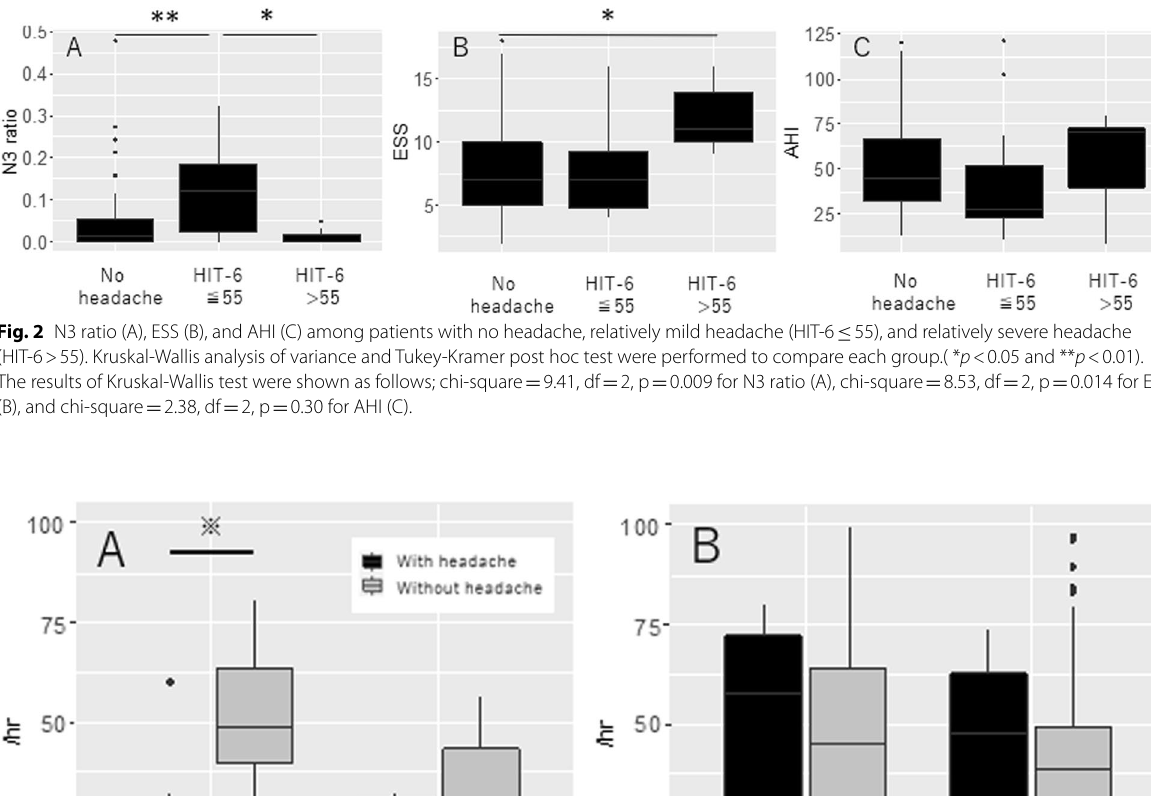
Fig. 3 AHI and AROI in patients with and without sleep apnea headache. Results for female are shown in A, and results for male in B. * p < 0.05 based on the Wilcoxon rank-sum